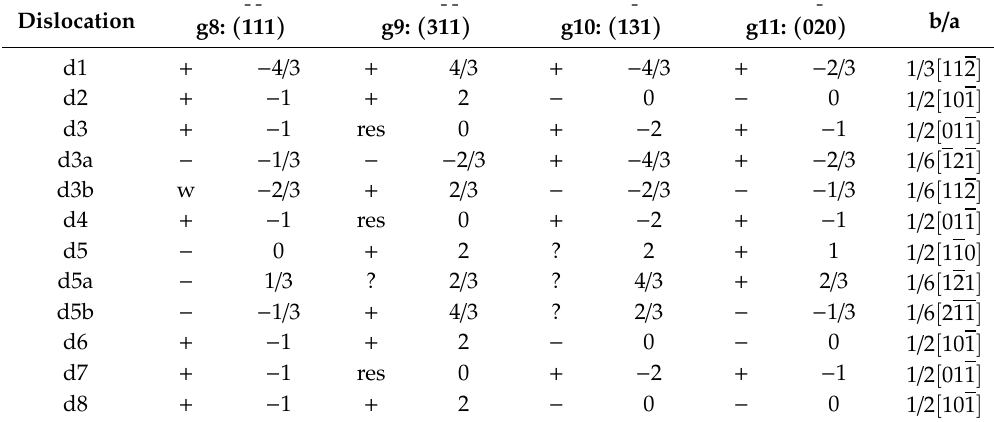
Table 4. E ff ective visibilities ( + ) and invisibilities (-) for g -vectors 8 to 11 from Table 2. Dislocation